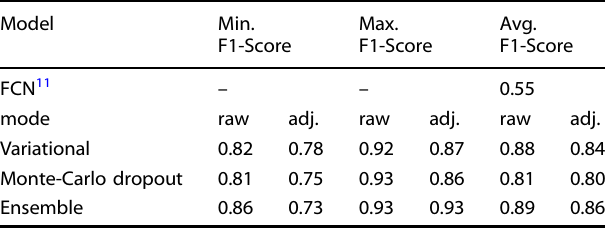
Table 1. Test set accuracy metrics for each of the model variants.